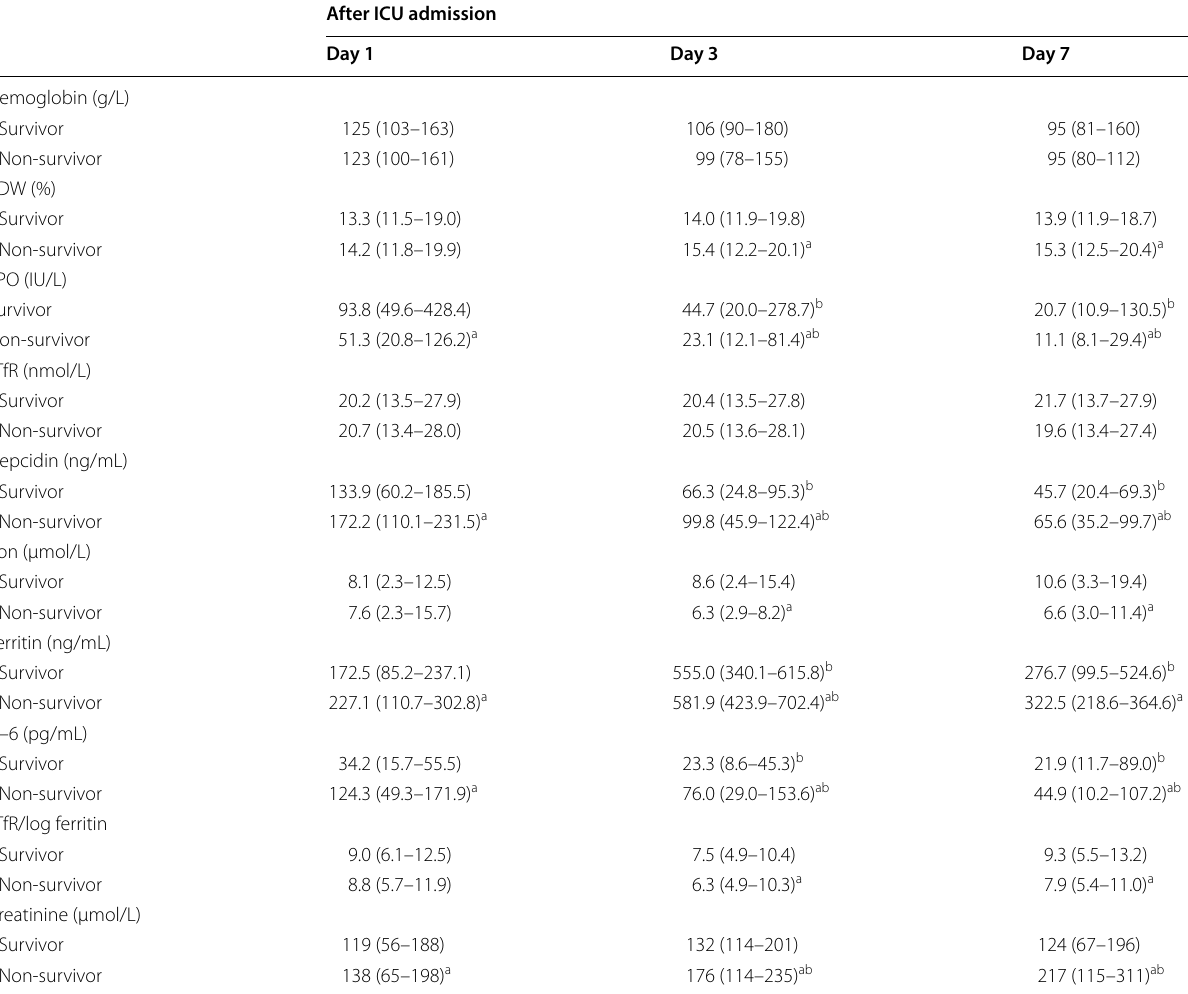
Table 3 Comparison of inflammatory anemia-associated parameters and creatinine levels of patients with sepsis in survivor and non-survivor